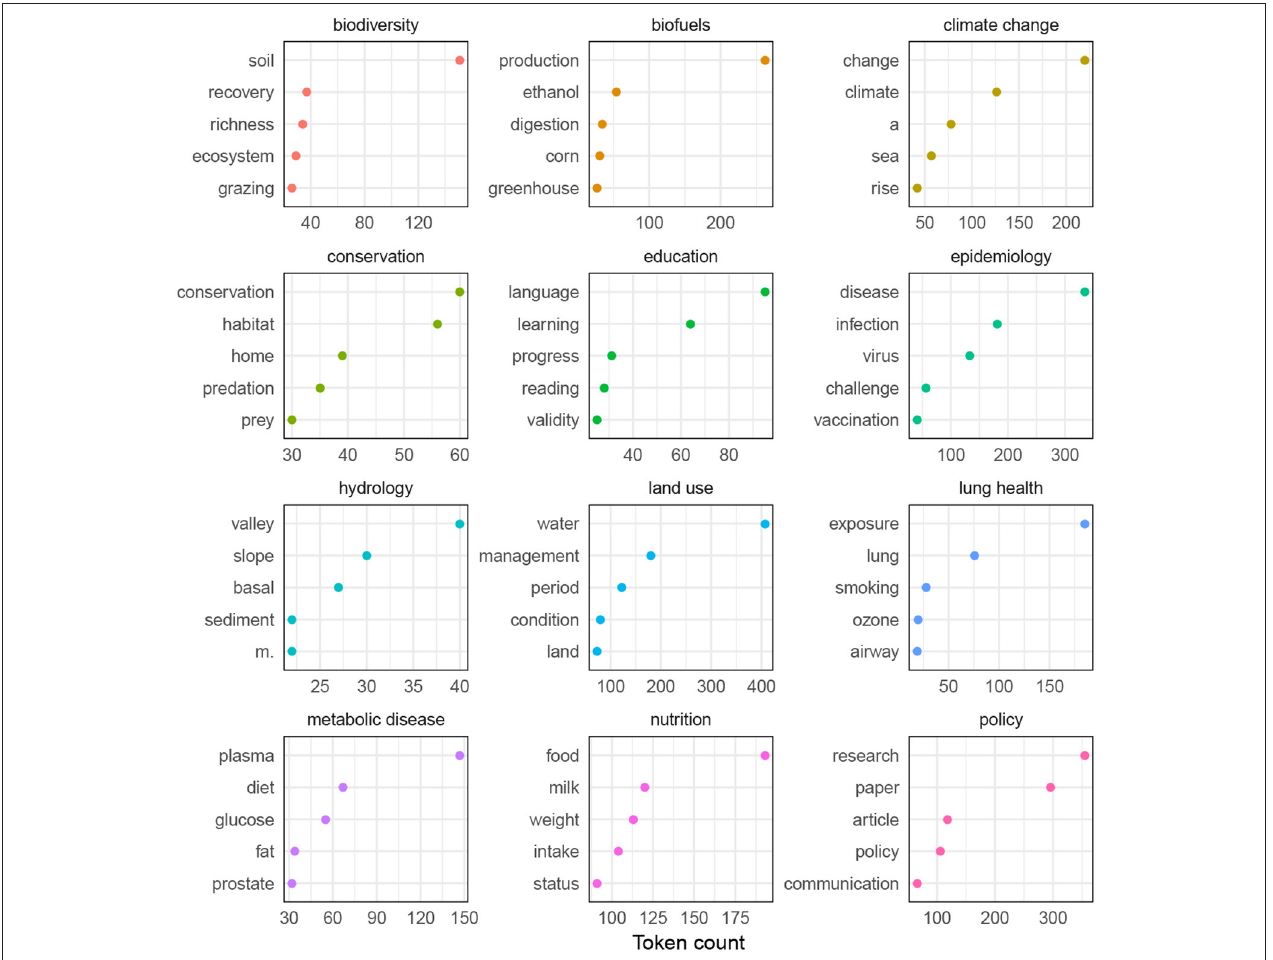
FIGURE 4 | The 5 most-prevalent terms for each selected cluster. Token counts are across the sample dataset. Point colors are not